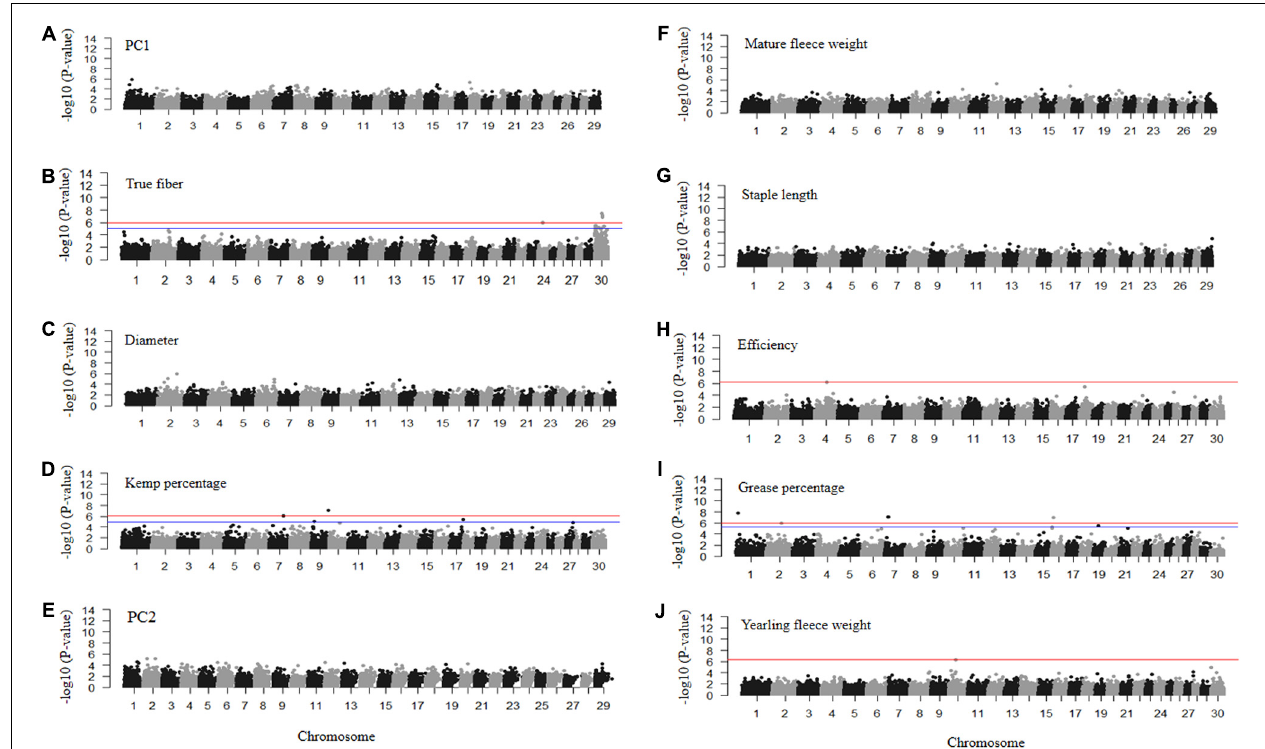
FIGURE 6 | Manhattan plots of –log10 ( P -values) for association of SNP loci for mohair traits (A) PC1 reflecting fiber quality, (B) true fiber percentage, (C) fiber diameter, (D) kemp percentage, (E) PC2 reflecting fiber volume, (F) mature fleece weight, (G) staple length, (H) efficiency, (I) grease percentage, and (J) yearling fleece weight. Traits with red and blue horizontal lines indicate Bonferroni and FDR corrected P -values of 0.05, respectively. Those with only a red horizontal line indicate P -values thresholds were the same for both Bonferroni and FDR. Those without horizontal lines reflect GWAS run using permutation